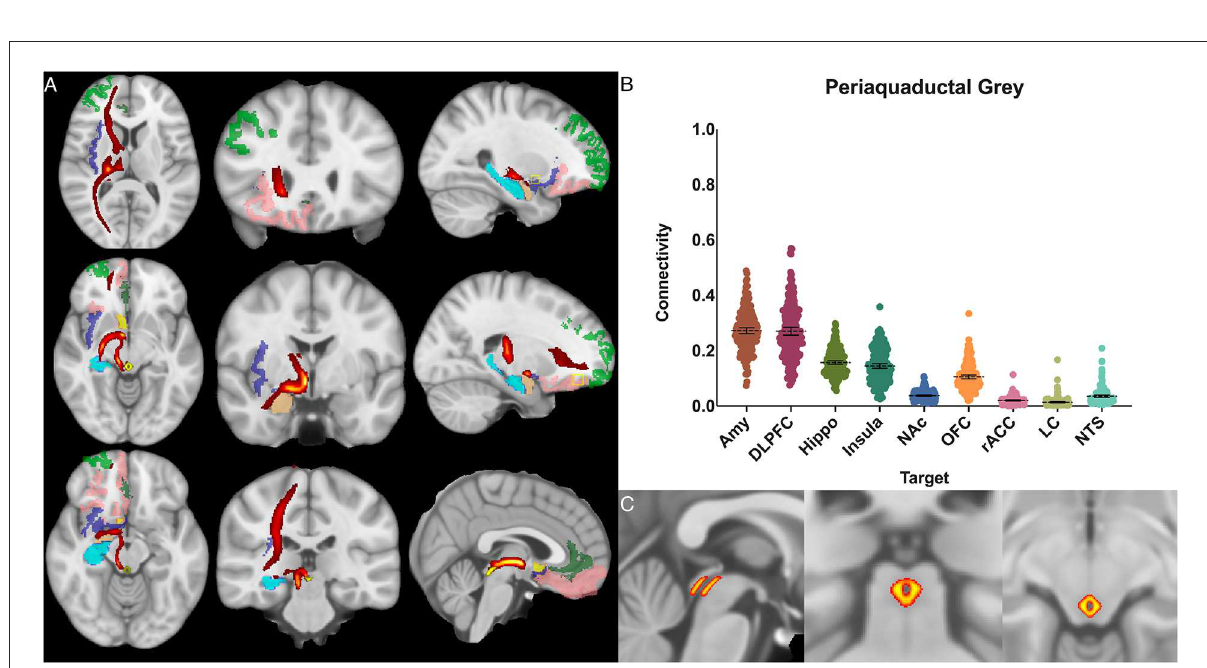
FIGURE6 Ventral tegmental area structural connectivity. (A) MNI space structural connectivity results visual representation averaged over all 197 subjects. Brighter yellow on heat map indicates a high number of samples passing through a given point that will eventually reach a target map (brighter yellow = more samples). Dark green: DLPFC; pink: OFC; brown: AMY; blue: HIPPO; purple: insula; orange: NAc; light green: rACC; (B) Mean connectivity results with dashed line showing mean and 95% CI, each point on graph shows result from individual subject. (C) Anatomic MNI mask of seed